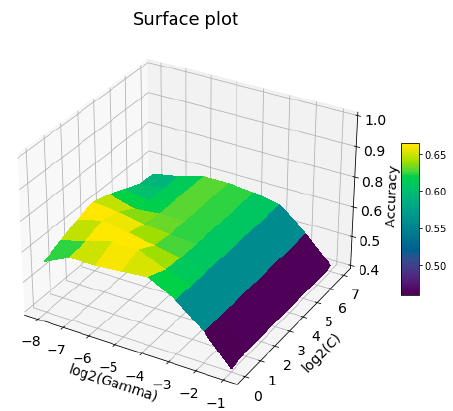
Figure 8. Performance of SVC by varying 𝐶 and 𝛾 .